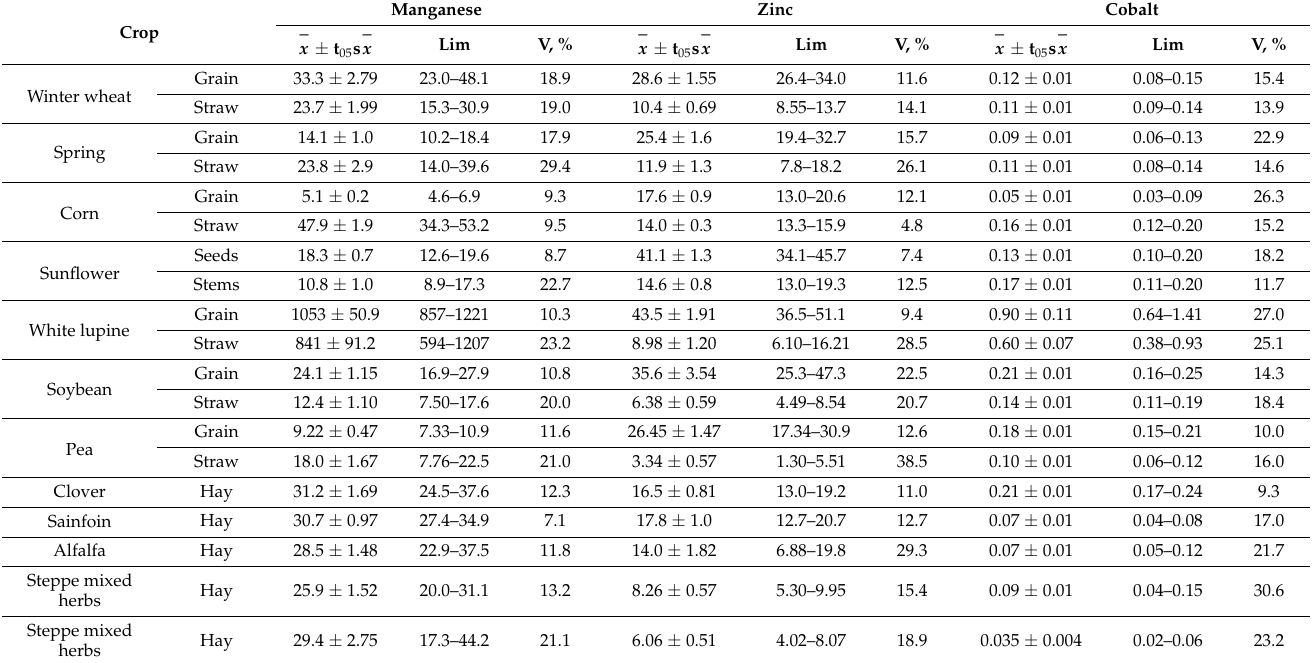
Table 6. Variation and statistical indices of trace element content in crop products, mg/kg of abso- lutely dry